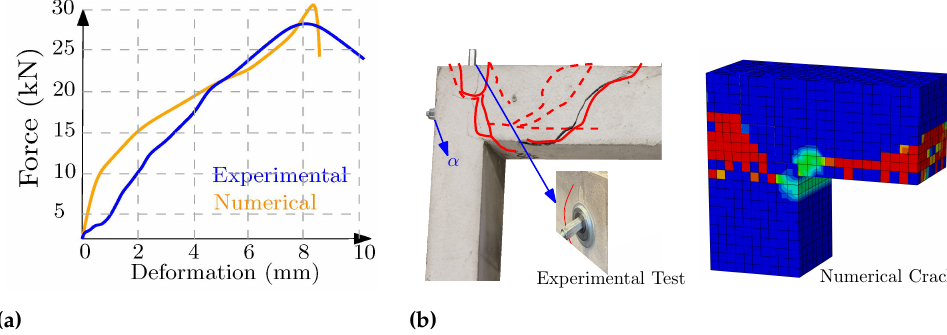
Figure 16. F6, ( a ) Force–deformation, ( b ) experimental cracking and numerical cracking